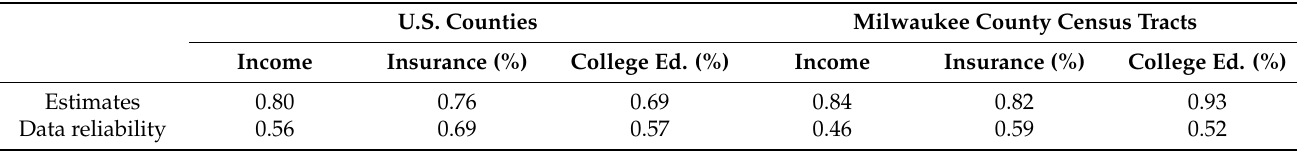
Table 1. Degree of SA in select ACS estimates and their respective measures of data reliability (CV for income, SEs for the others).